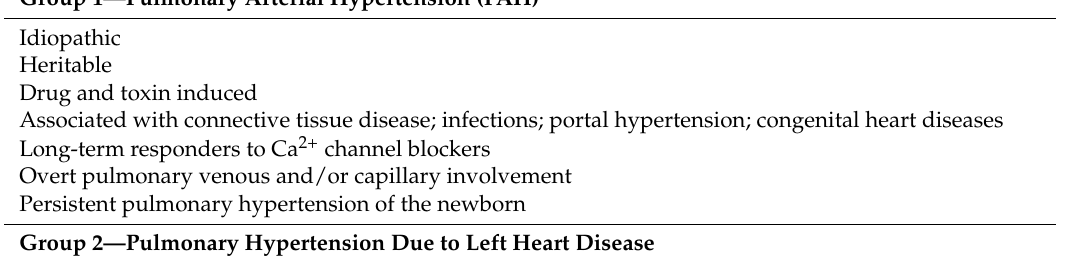
Table 1. Clinical classification of pulmonary hypertension